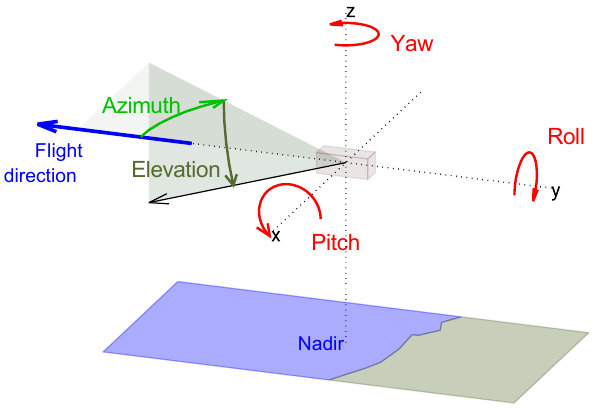
Figure 1. Sketch defining the attitude angles (roll, pitch, yaw) and the viewing angles (azimuth,